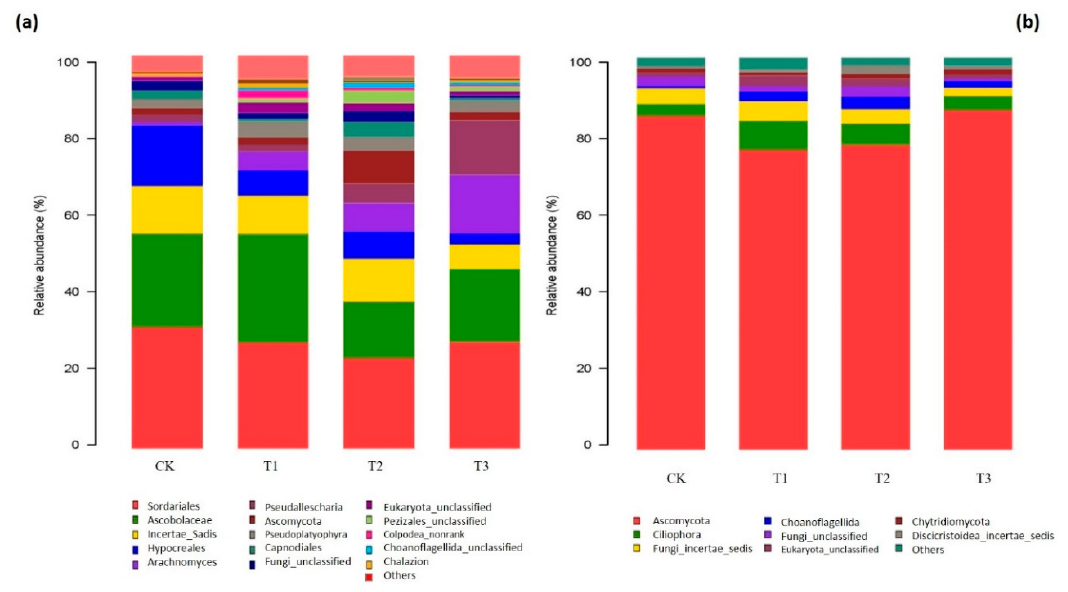
Figure 4. ( a ) Relative abundances of fungal community composition at the genus level. ( b ) Relative abundances of community proportions of fungal samples at the phylum level under different treatments.